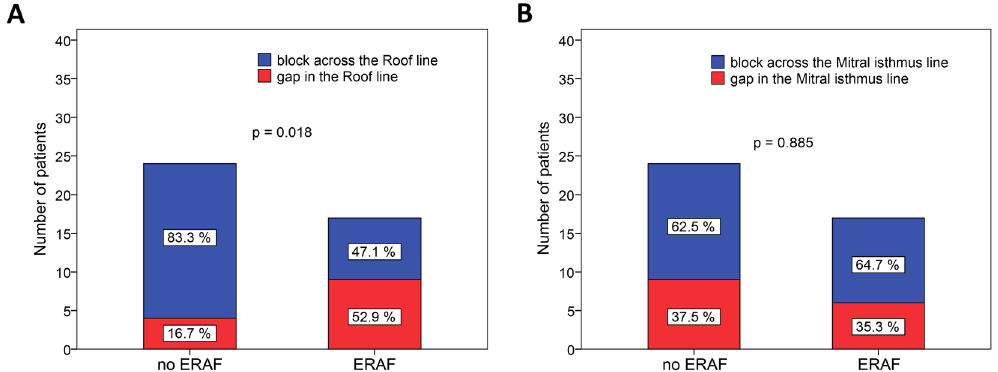
Figure 5. The prevalence of 3-month conduction gap in the Roof line ( A ) and the Mitral isthmus line ( B ) in relation to the ERAF history during the blanking period. ERAF, early recurrence of atrial